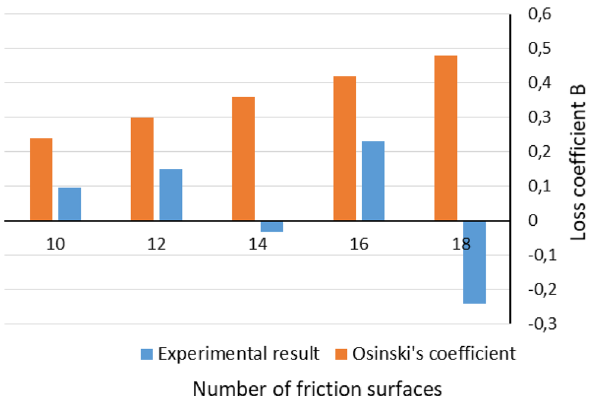
Figure 13. Comparison of experimentally obtained values of loss coefficient B with Osinski’s coefficients.